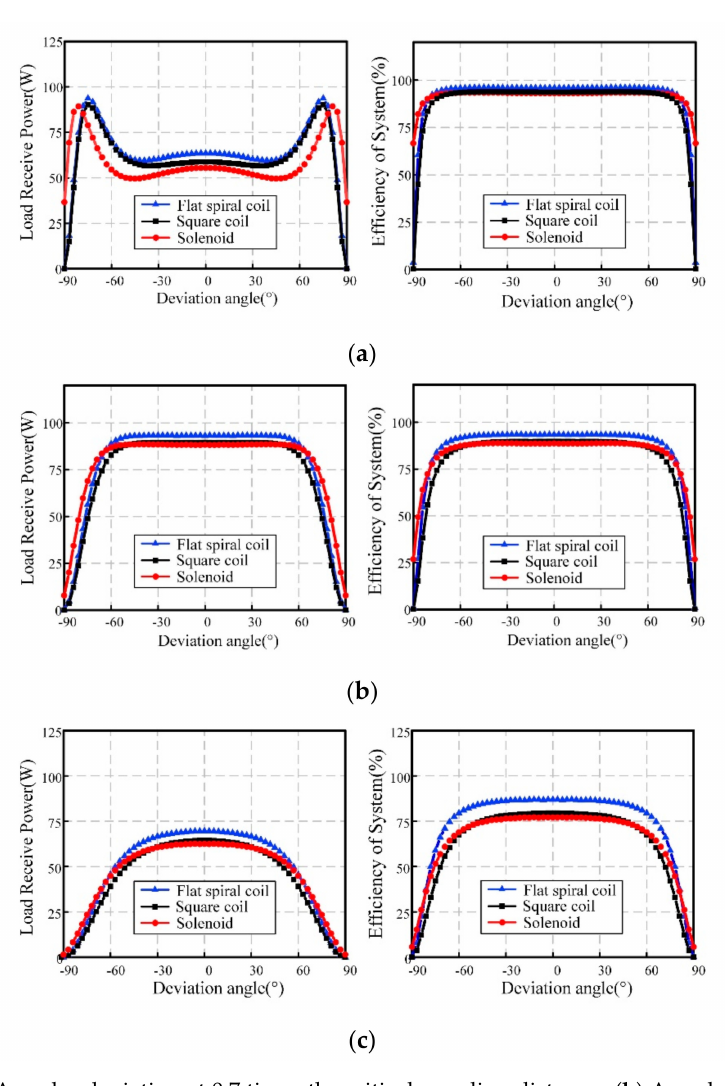
Figure 7. ( a ) Angular deviation at 0.7 times the critical coupling distance. ( b ) Angular deviation at critical coupling distance. ( c ) Angular deviation at 1.3 times the critical coupling distance.